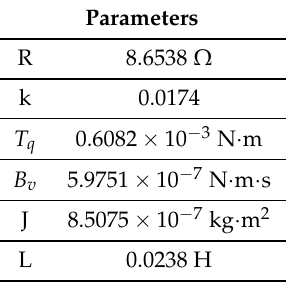
Table 1. Estimated Motor-Gearbox Parameters.